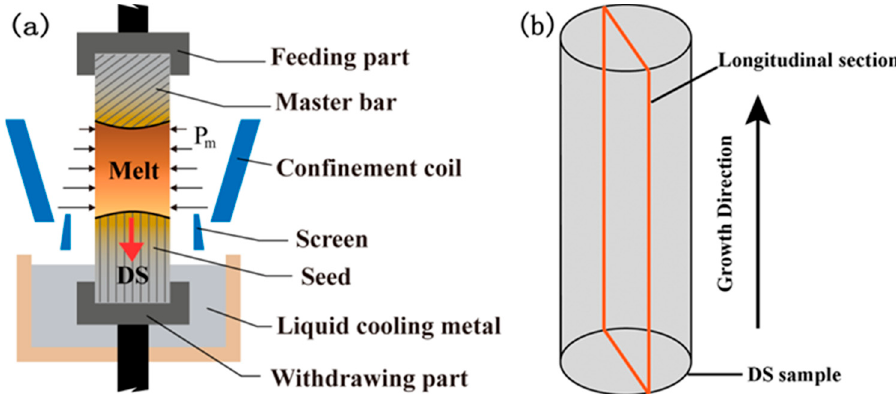
Figure 1. Schematic illustration of electromagnetic confinement and directional solidification sys- tem ( a ) and the sectioned longitudinally of the DS bar by EDM ( b ). φ 20 mm master alloy bars and seed alloy bars were cut from φ 65 mm ingot